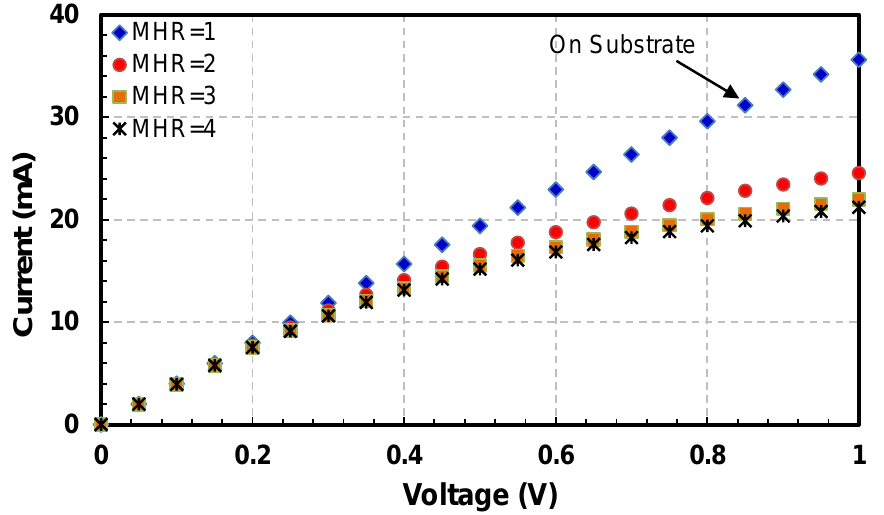
Figure 6. I − V curves of SOI CMOS MEMS hot-film sensors FS1, FS3, FS5 and FS7 having square membranes: For FS1 sensor with MHR = 1 (that has partially etched membrane), the I-V curve is almost linear indicating negligible change in sensor’s resistance (i.e., no heating). With increasing MHR in FS3, FS5 and FS7 sensors (i.e., MHR = 2, 3, 4, respectively), the Joule heating and resistance increase significantly.